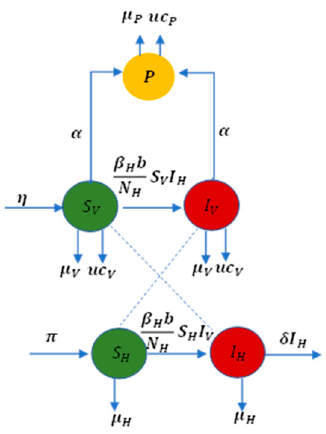
Figure 6. Schematic diagram of the spread of tungro disease in rice plants conducted by Suryaningrat et al. [20].